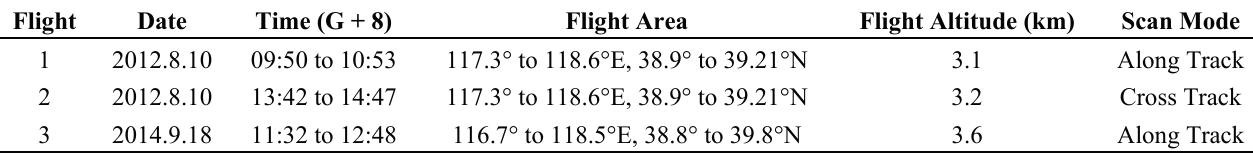
Figure 1. Flight tracks of the first and second flights on 10 August 2012 (green line) and that of the third flight on 18 September 2014 (red line). Star symbols indicate ground-based CE318 Sun-sky radiometer sites for validation. The dashed square is the research area for Flights 1 and 2. Table 1. Flight information of AMPR test